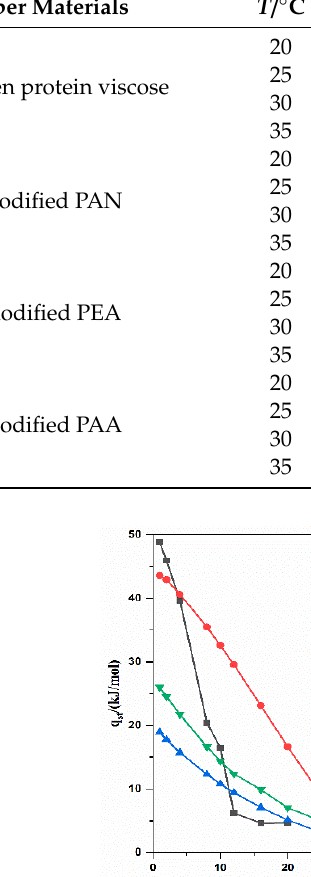
Table 3. Parameters of four kinds of hygroscopic exothermic fibers after fitted by the GAB model. Fiber Materials T / ◦ C m 0 / %